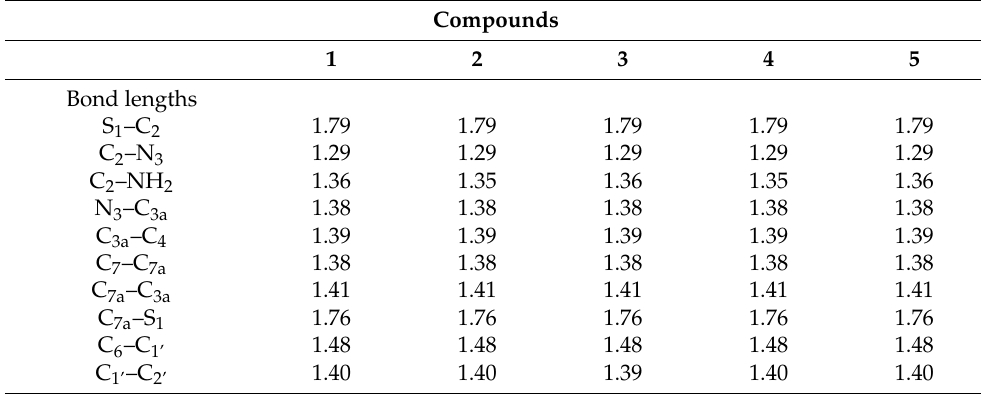
Figure 2. Optimized geometries of benzothiazole derivatives 1 to 5 . Table 1. Selected bond lengths, bond angles and dihedral angles of 1 to 5 .